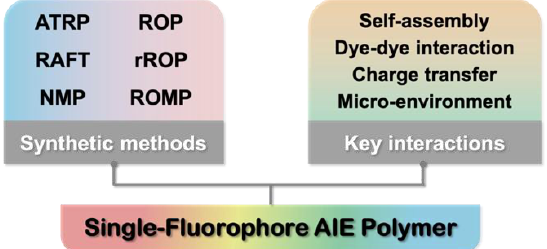
Figure 1. Schematic illustration of the main synthetic methods and key interactions involved in single-fluorophore AIE polymers.